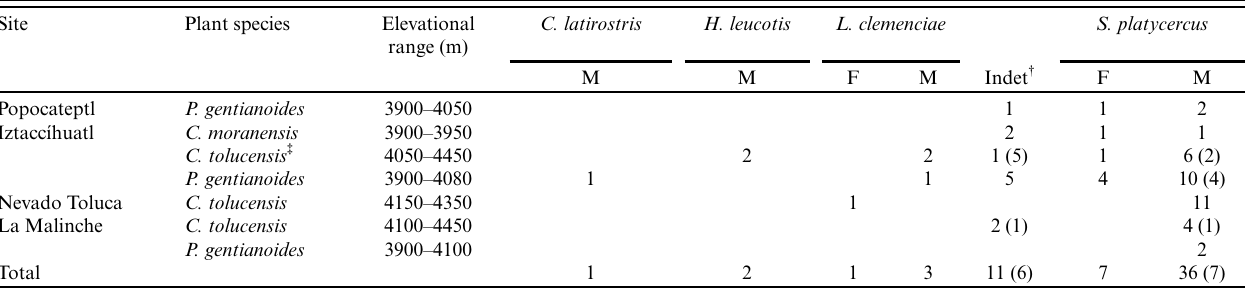
Table 1 . Number of female (F) and male (M) hummingbirds observed at alpine sites of four volcanoes of the Transmexican Vocanic Belt during 2014–2017. Numbers in parentheses indicate additional individuals recorded only from bird calls. Site Plant